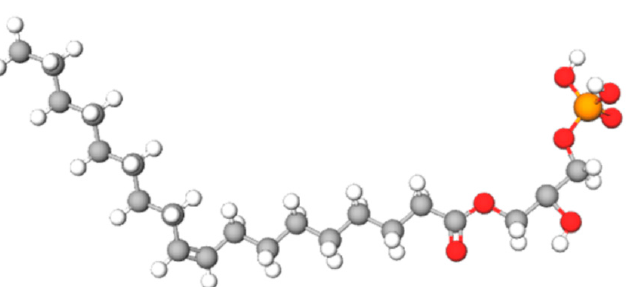
Figure 1. LPA structure. Chemical structure of 1-oleoyl-2-hydroxy-sn-glycerol-3-phosphate (LPA 18:1). Atoms in the chemical structure: Carbon (grey), Hydrogen (white), Oxygen (red), and Phosphorus (orange) (https://pubchem.ncbi.nlm.nih.gov/compound/Lysophosphatidic-acid) (https://molview.org). Accessed on 04 June 2021.